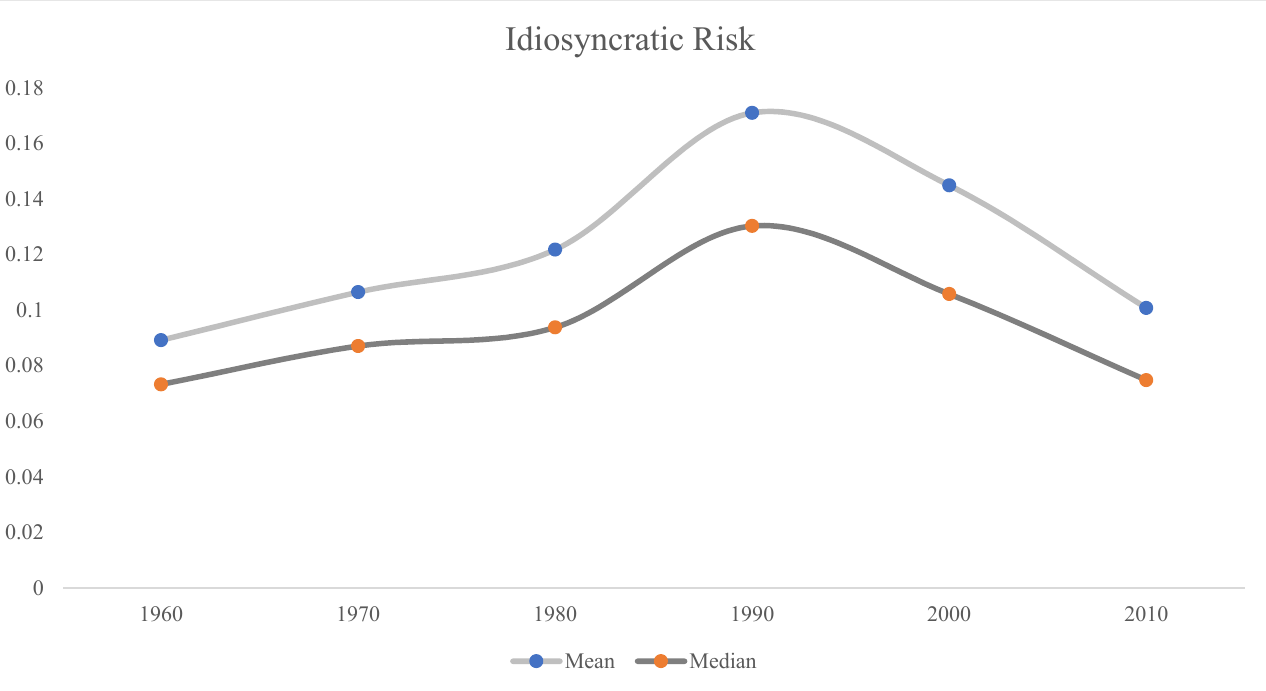
Figure 2. Historical trend in idiosyncratic risk. This figure shows the historical patten of idiosyncratic risk. Every decade from 1963 to 2019, the mean and median of idiosyncratic risk of individual stocks are plotted. The calculation of idiosyncratic risk is discussed in Equation (1).